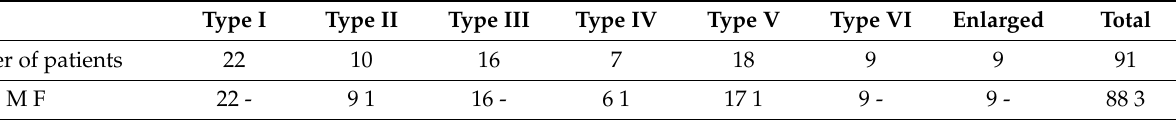
Table 3. Clinical outcome and follow-up.